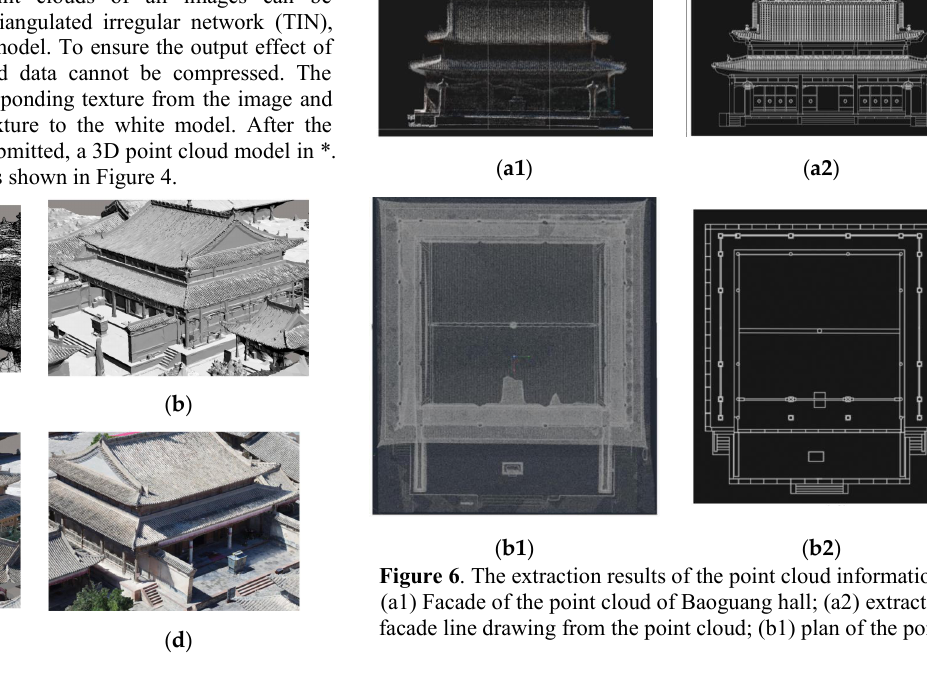
Figure 5 . The point cloud data of Baoguang hall in the CAD2014.